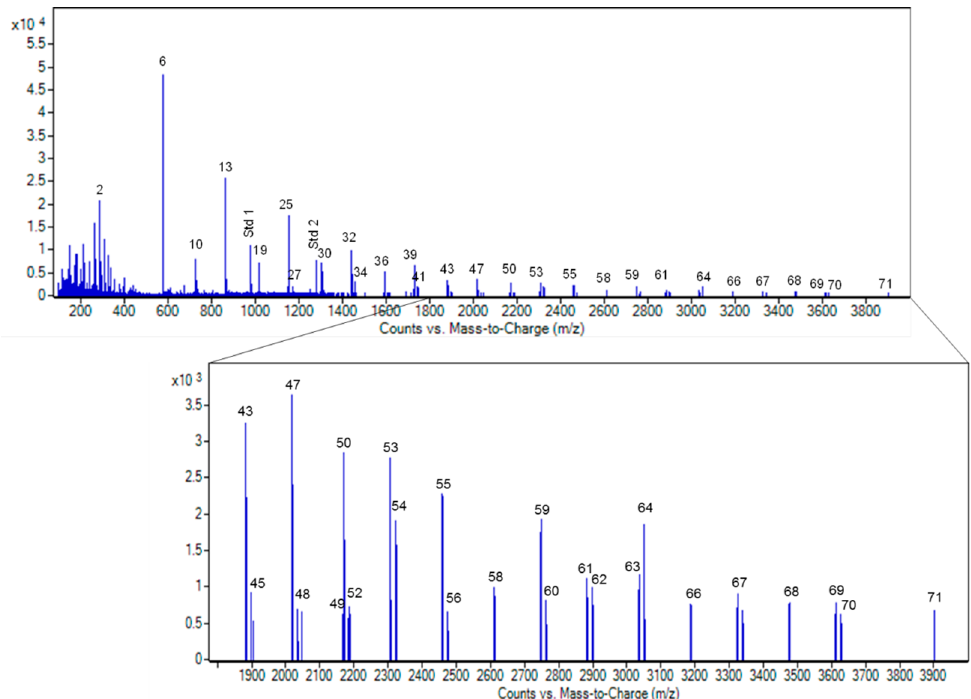
Figure 6. Deconvoluted ESI Q-TOF mass spectrum of Ecovitis™ grape seed extract. Compounds are identified with ID numbers as in Table 2.